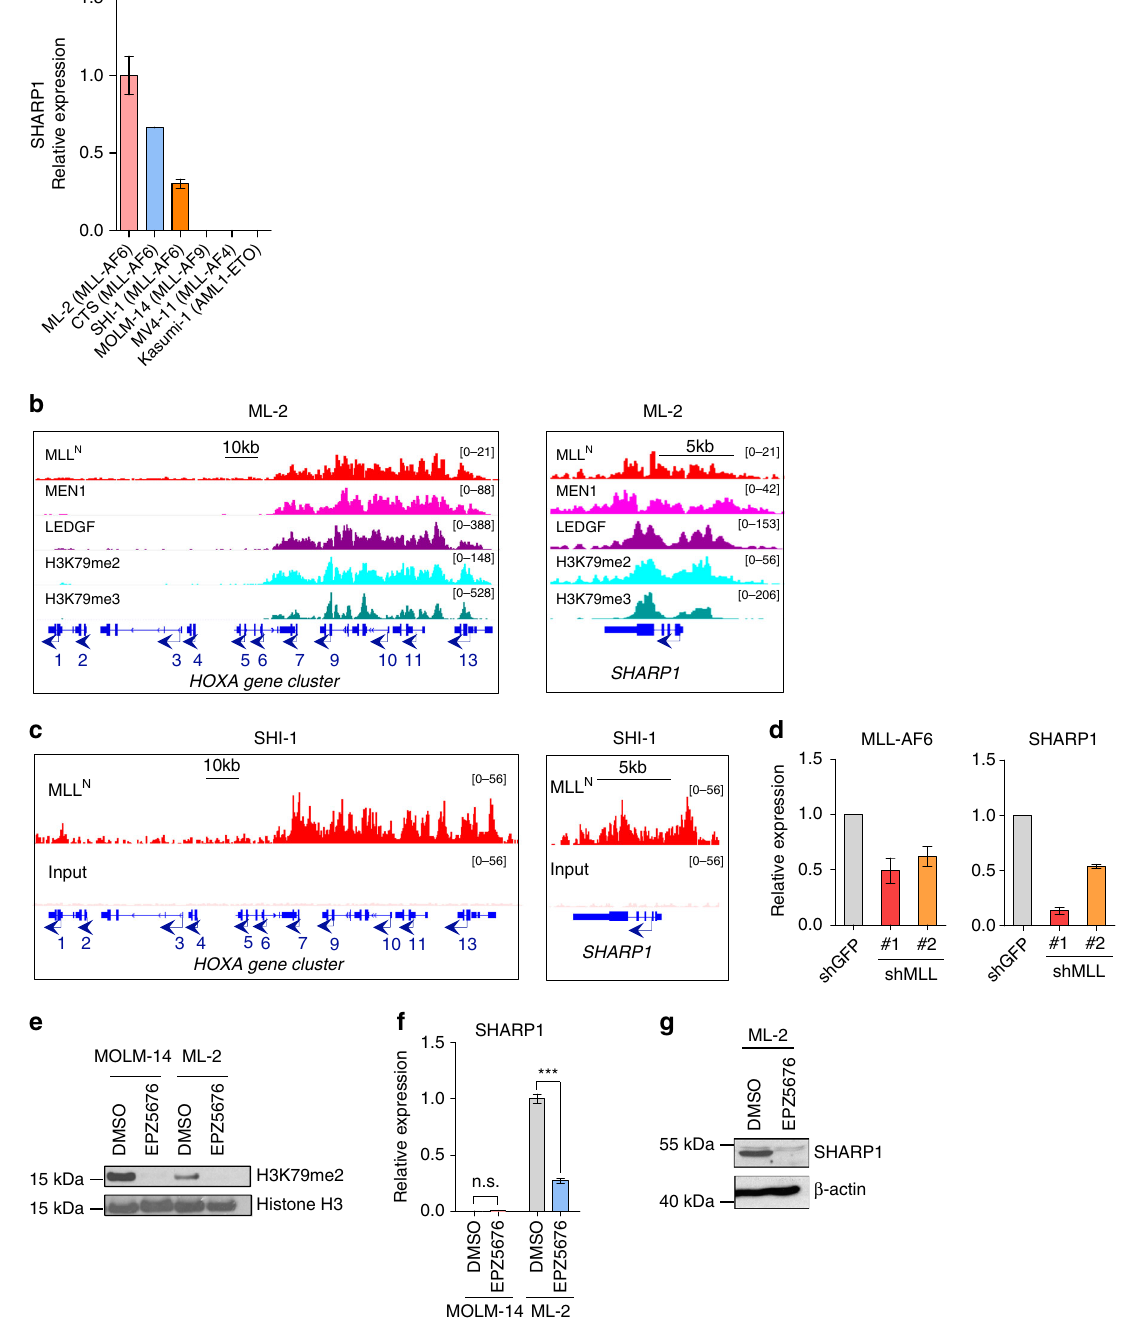
Fig. 2 SHARP1 is a downstream target of MLL-AF6 and DOT1L. a SHARP1 mRNA expression in human AML cell lines assessed by qPCR. The cell lines analyzed are: ML-2 (MLL-AF6), CTS (MLL-AF6), SHI-1 (MLL-AF6), MOLM-14 (MLL-AF9), MV4-11 (MLL-AF4), and Kasumi-1 (AML1-ETO). b ChIP-seq pro fi les of ML-2 cells using MLL N , MEN1, LEDGF, H3K79me2, and H3K79me3 antibodies at the loci of the HOXA gene cluster (left panel) and SHARP1 gene (right panel). c ChIP-seq pro fi les of SHI-1 cells using MLL N antibody and input at the loci of the HOXA gene cluster (left) and SHARP1 gene (right). d qPCR for MLL-AF6 (left panel) and SHARP1 (right panel) mRNA expression in ML-2 cells upon MLL knockdown. Shown is the relative expression value to ML-2 transduced with shGFP. e Western blot of H3K79me2 in MOLM-14 (MLL-AF9) and ML-2 (MLL-AF6) cells treated with the DOT1L inhibitor, EPZ5679 (1 μ M) or DMSO vehicle for 96 h. f qPCR for SHARP1 mRNA in MOLM-14 or ML-2 cells treated with EPZ5679 or DMSO vehicle for 6 days. Relative expression is the value compared to ML-2 cells treated with DMSO vehicle. g Western blot of SHARP1 and β -actin in ML-2 cells treated with EPZ5679 or DMSO vehicle for 10 days. All Western blots are representative of three independent experiments. All quantitation data include three independent experiments and are presented as mean ±